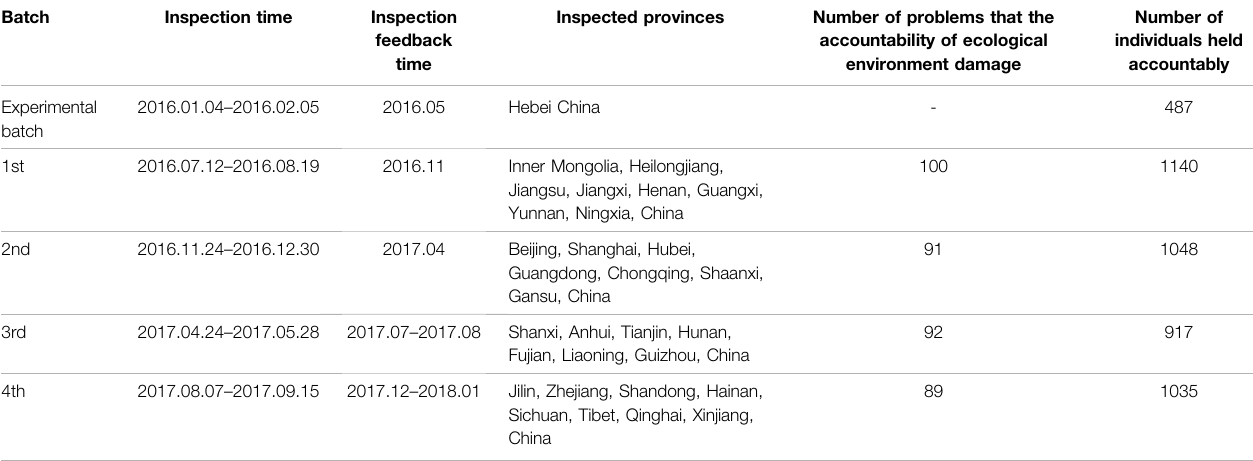
TABLE 1 | Implementation effectiveness of the fi rst round of central environmental inspections.